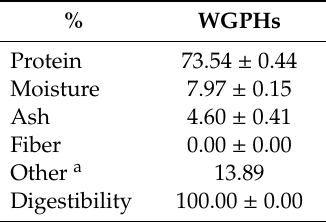
Table 1. Chemical composition of wheat gluten protein hydrolysates (WGPHs).